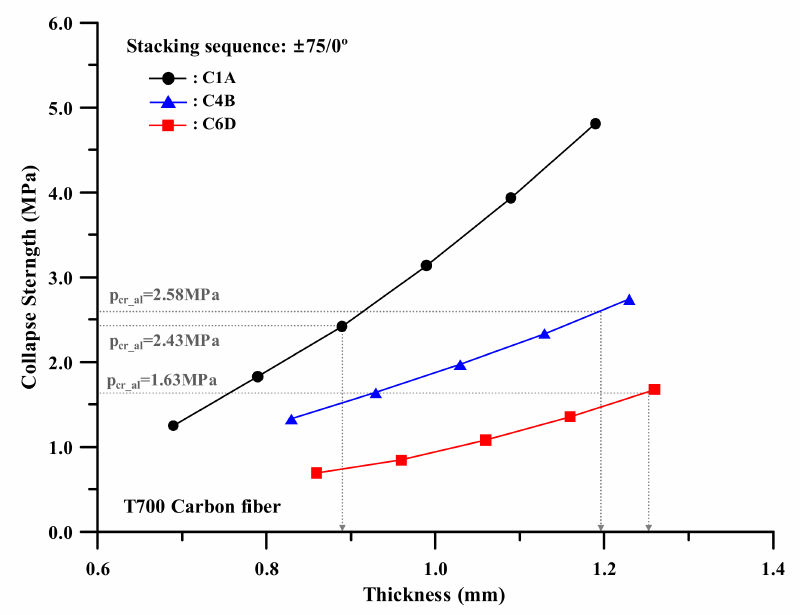
Figure 10. Collapse strength comparison depending on stacking angle or material with identical weight. ( a ) Variation in composite material with stacking angle, ( b ) Comparison between aluminum and composite material of ± 75/0.